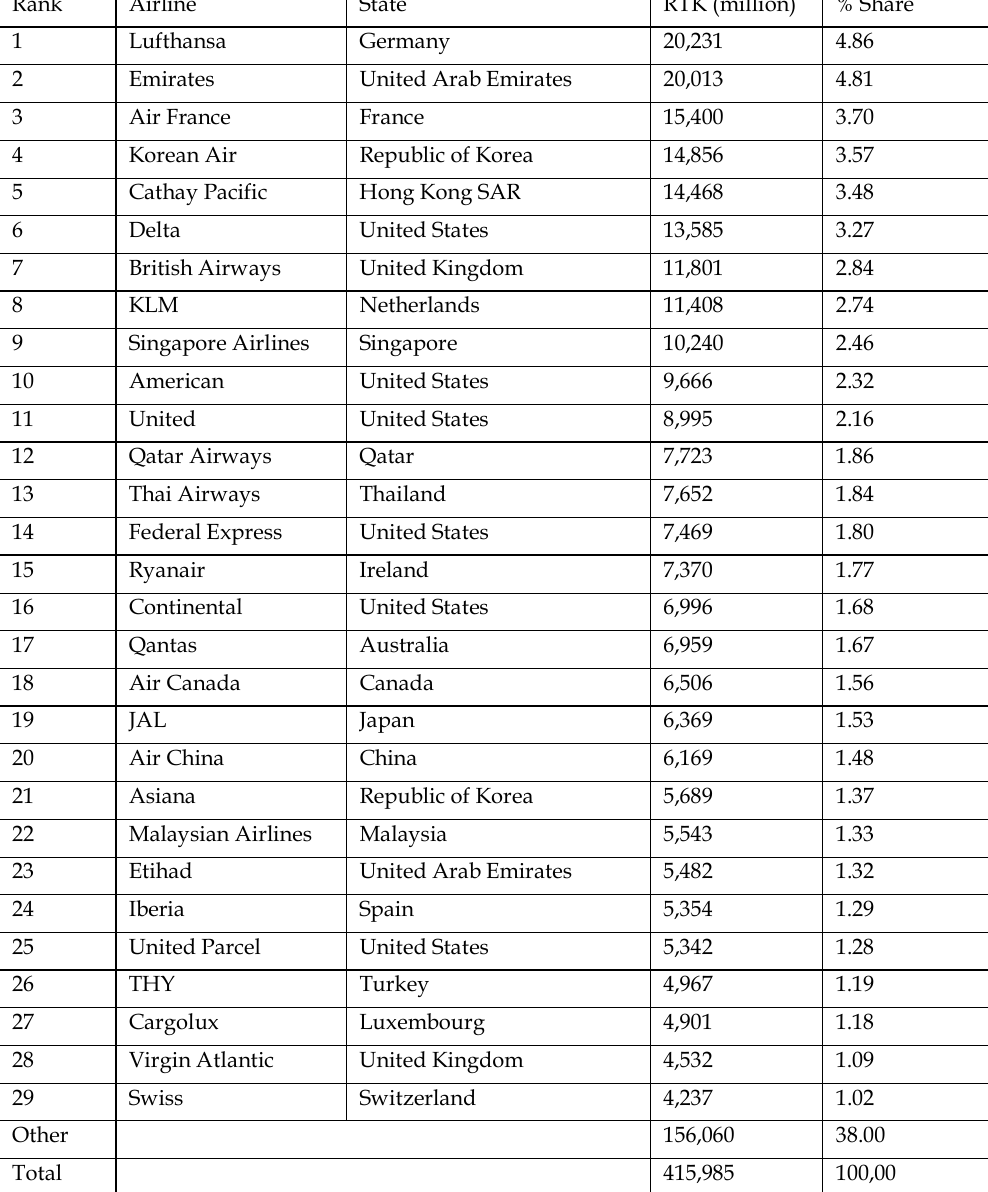
Table 6. Airlines Ranking according to the share of global international air traffic revenue tonne kilometres (RTK) in